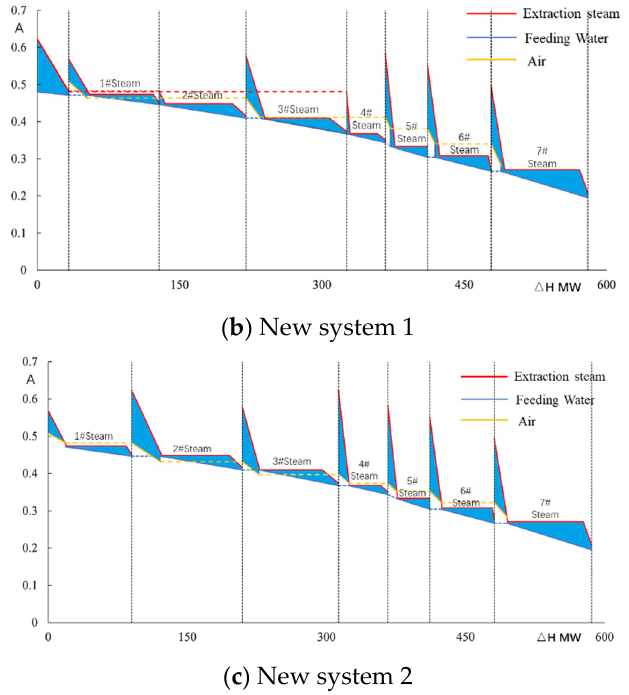
Figure 10. EUD diagrams of seven-stage regenerative steam extraction heat transfer processes of original system and new systems.